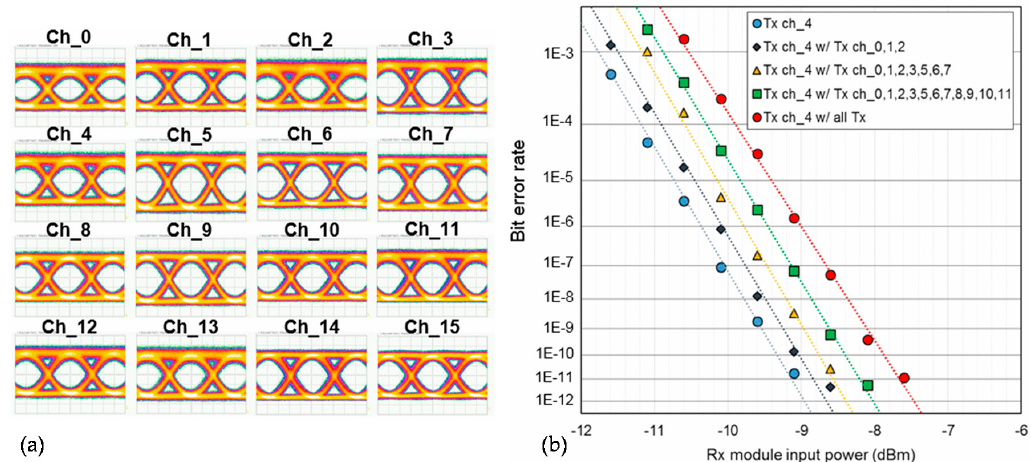
Figure 12. ( a ) Optical eye diagrams of all transmitter channels and ( b ) the sensitivity changes of ch_4 at multi-channel transmitters operations; Ch_1: the first channel; TX: transmitter; Rx: receiver; (From [28] © 2021 IEEE).